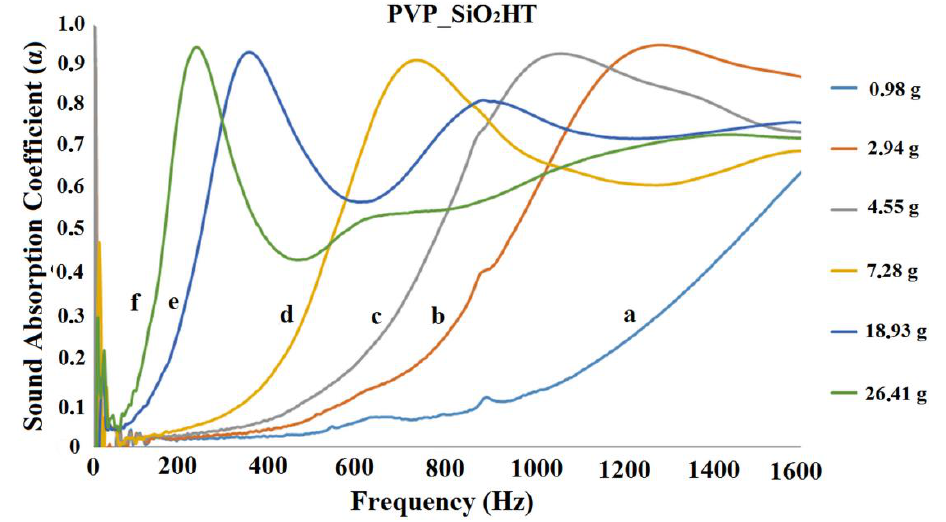
Figure 13. Plots of the sound absorption coefficient as a function of frequency for various PVP_SiO 2 HT disks piles. The a, b, c, d, e and f curves refer, respectively, to samples of total mass 0.98 g, 2.942 g, 4.55 g, 7.28 g, 18.93 g and 26.41 4.55 g, 7.28 g, 18.93 g and 26.41 g.